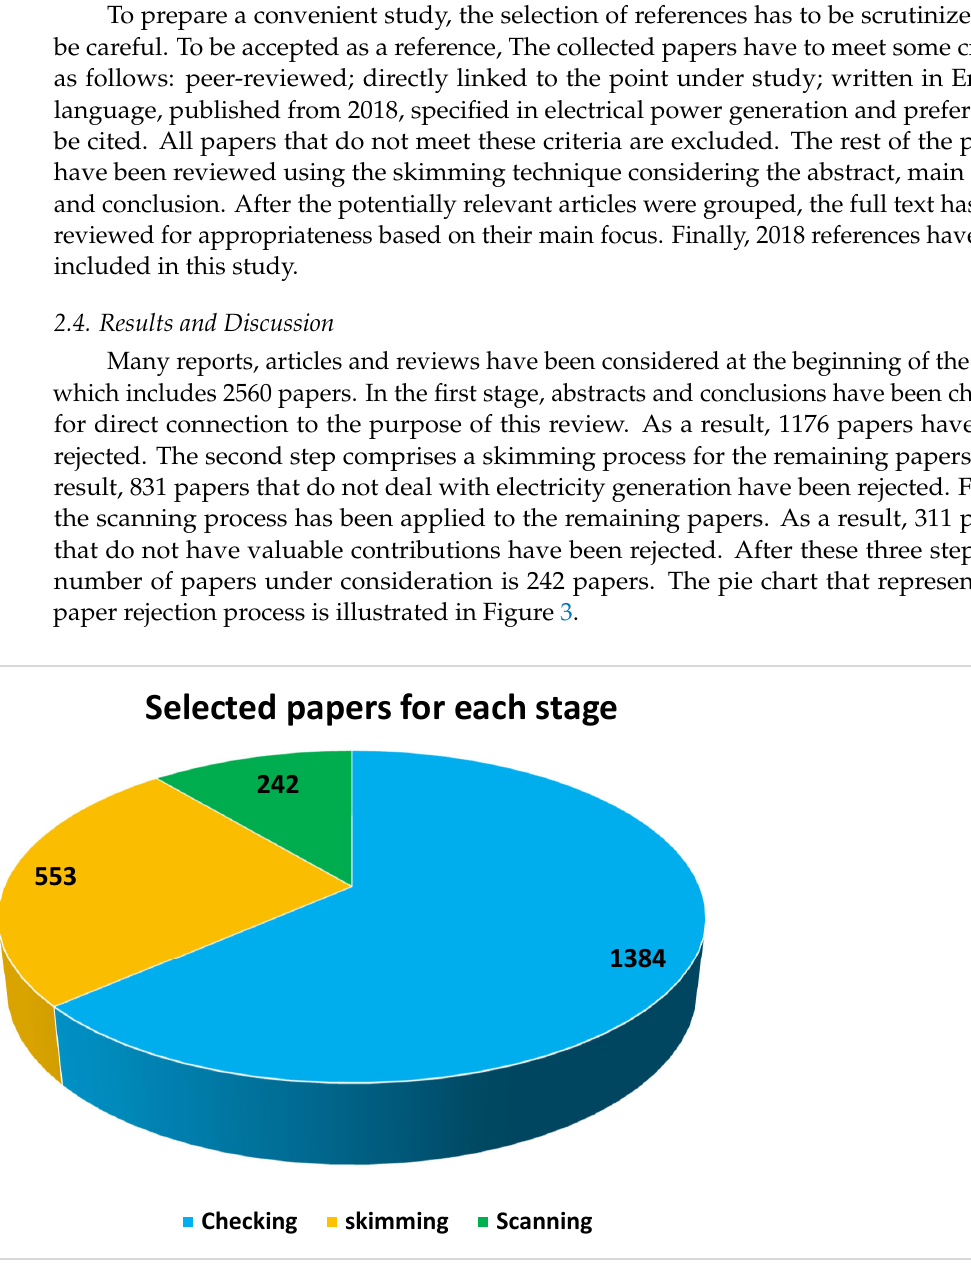
Figure 3. Research selection for each stage.